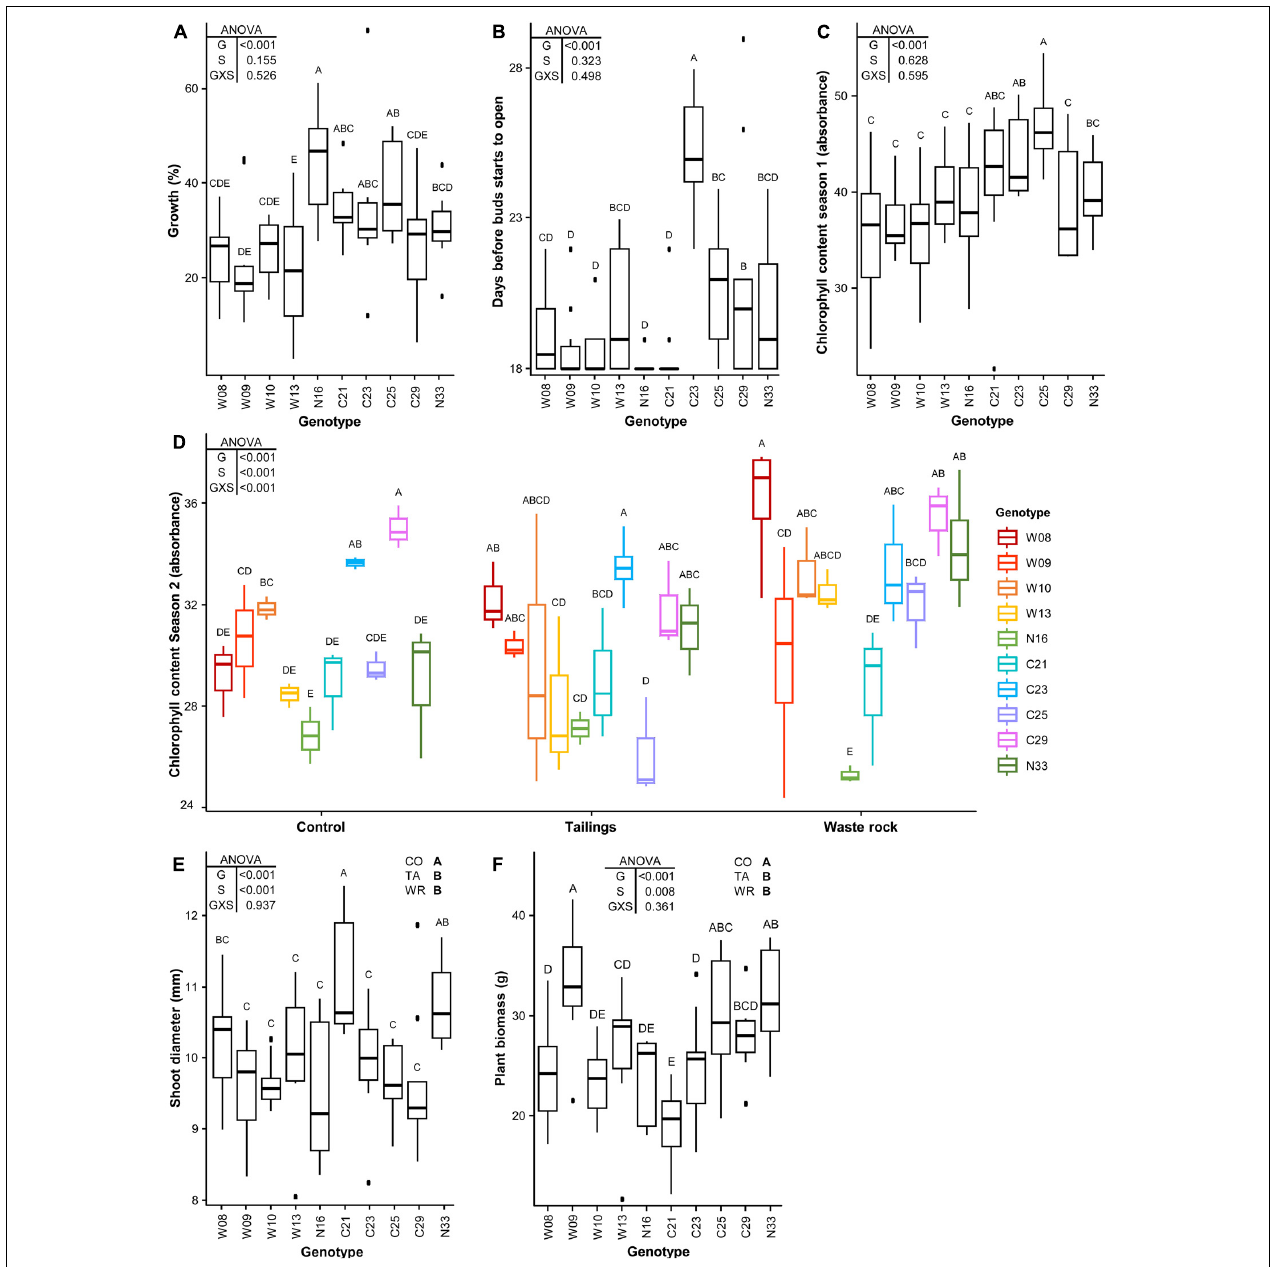
FIGURE 3 | Effect of genotype and substrate type on tree growth measurements. Tree growth during the first season (A) ; chlorophyll content at the end of the first (B) and second (C) seasons; blooming during the second season (D) ; shoot diameter (E) ; and biomass produced during the second season (F) . A two-way ANOVA was used to discern how genotype, substrate type and their interaction influenced tree growth measurements. Shared letters between treatments means there is no significant difference between these treatments as determined by Tukey HSD post hoc pairwise comparison test ( n ≥ 3). In the ANOVA tables, G is genotype; S is substrate type; and GXS is the interaction between genotype and substrate type. In (E) and (F) CO is control; TA is tailings; and WR is waste rock. Significance level is p < 0.05. In (A–C) , because only the effect of genotype is significant, measures from all substrate types were pooled. In (D) , because the interaction of both factors is significant, all treatments were shown separately. In (E) and (F) , pooled measures from all substrate types are shown for each genotype as a boxplot and the effect for each substrate type is shown in the upper right corner of the